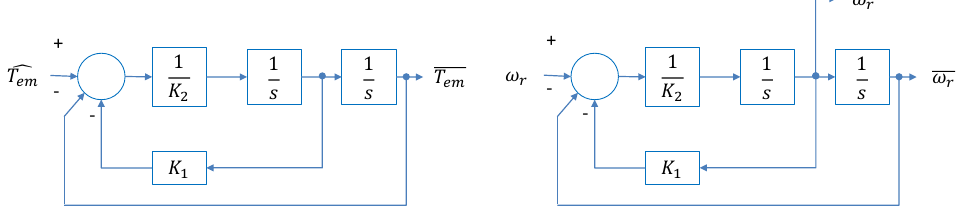
Figure 2. Filtering for extracting the electromagnetic torque and rotor speed with a derivative through integral